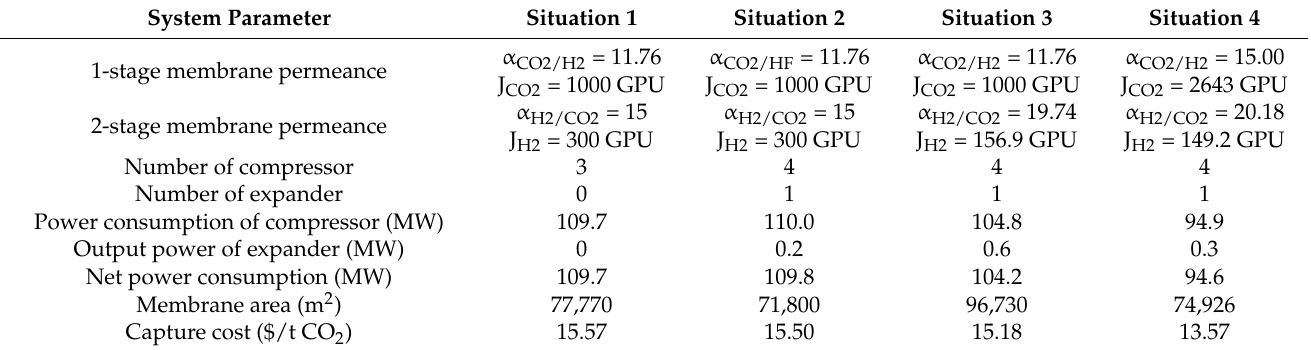
Figure 17. Impact of different optimization on cost in different situations. Table 8. Comparison of different situations under the conditions of 99% purity and 90% recovery.